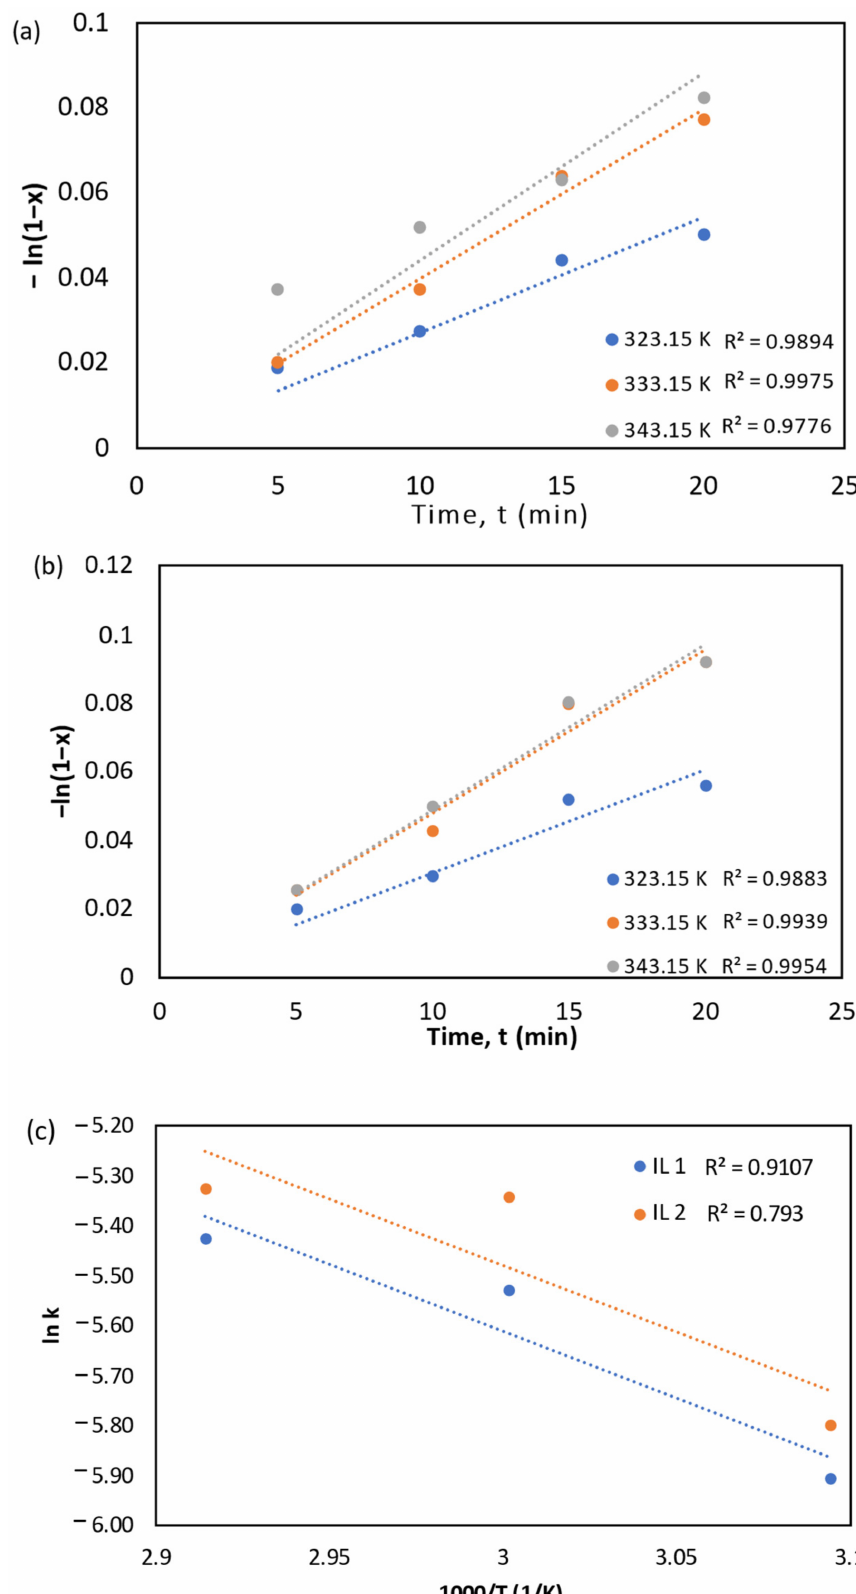
Figure 6. First order reaction for the DT of microalgae at different temperature using IL 1 ( a ) and IL 2 ( b ) and the Arrhenius plot ( c